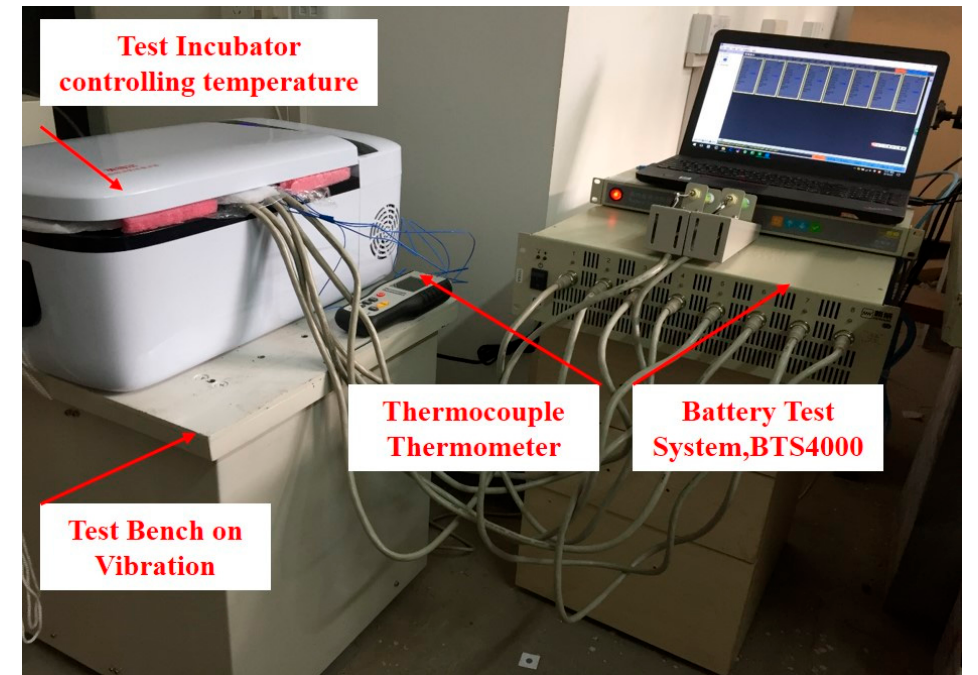
Figure 1. The test platform of the temperature-vibration coupling conditions.